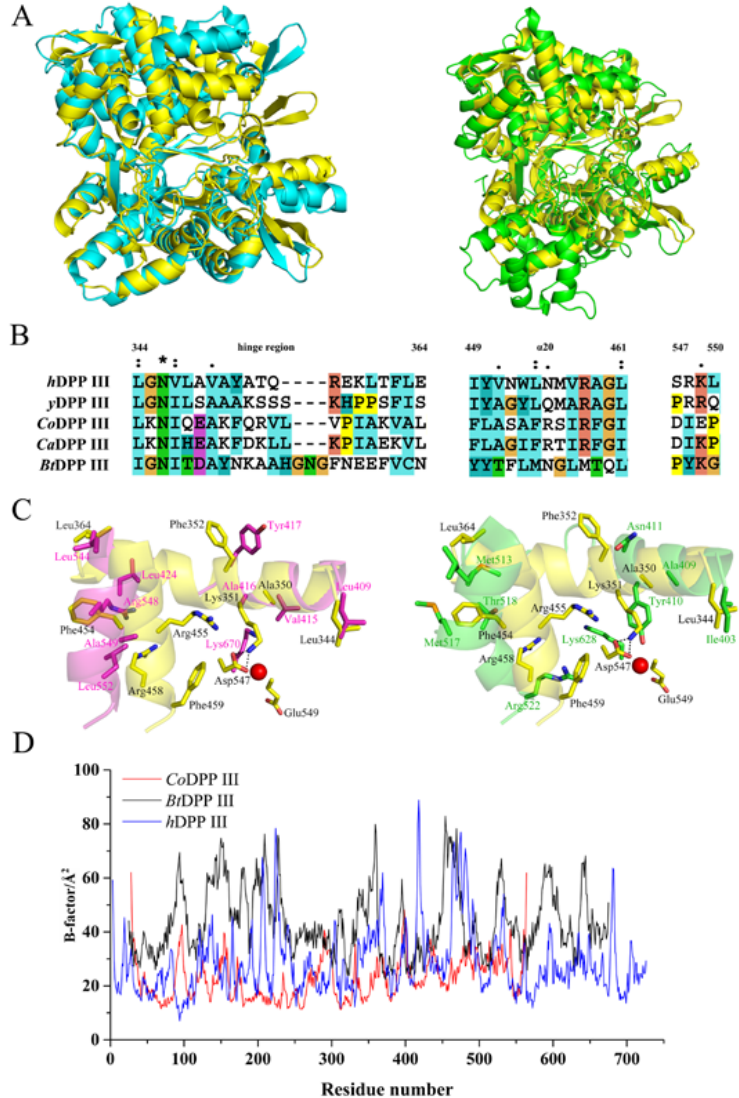
Figure 6. Structure and sequence comparison of Co DPP III with other DPP III. ( A ) Structure overlay of Co DPP III (yellow) with Ca DPP III (cyan, PDB ID: 6EOM) and closed Bt DPP III (green, PDB ID: 5NA8). ( B ) Sequence alignment of the hinge region. Amino acid residues in Co DPP III are noted above the sequences. ( C ) Structural alignment of the hinge region of Co DPP III (yellow) with closed h DPP III (magenta, PDB ID: 3T6B) and closed Bt DPP III (green, PDB ID: 5NA8). The catalytic zinc ion is represented by a red sphere. ( D ) Residue based B-factors of Co DPP III, Bt DPP III, and h DPP